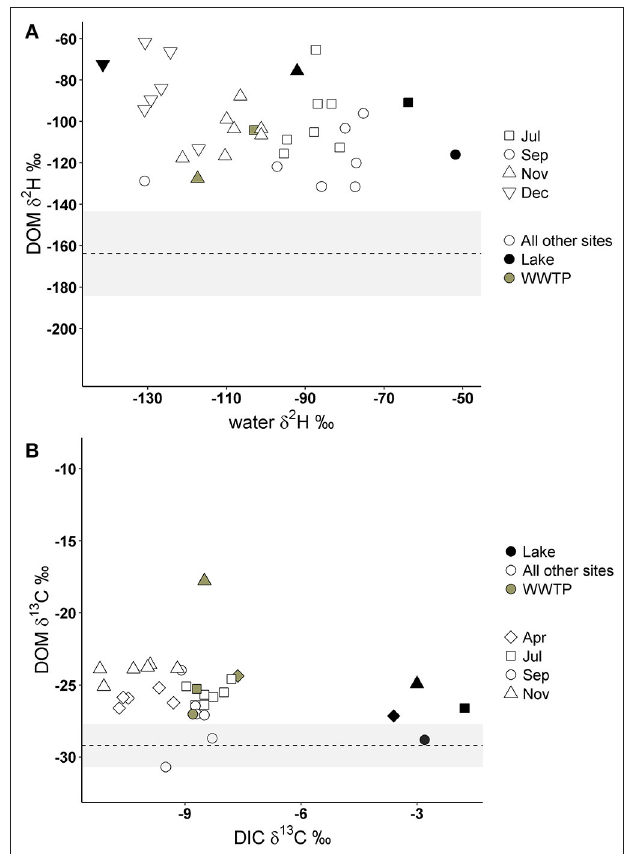
FIGURE 7 | Deuterium values of DOM compared to δ 2 H-water (A) and δ 13 C-DOM compared to δ 13 C of dissolved inorganic carbon (DIC; B ). The dashed lines and gray area represent the average δ 2 H and δ 13 C values of terrestrial sources collected in this study (see Table 1 ). Gray circles represent FPOM collected from WWTP effluent, black circles from Utah Lake, and open circles are FPOM collected from all other